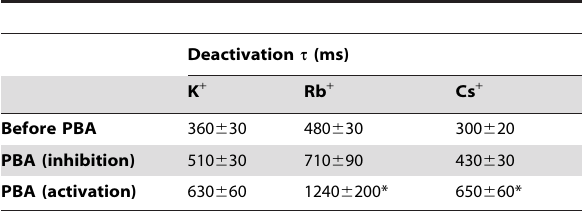
Table 2. Deactivation rates of Q1 with different charge carriers. b